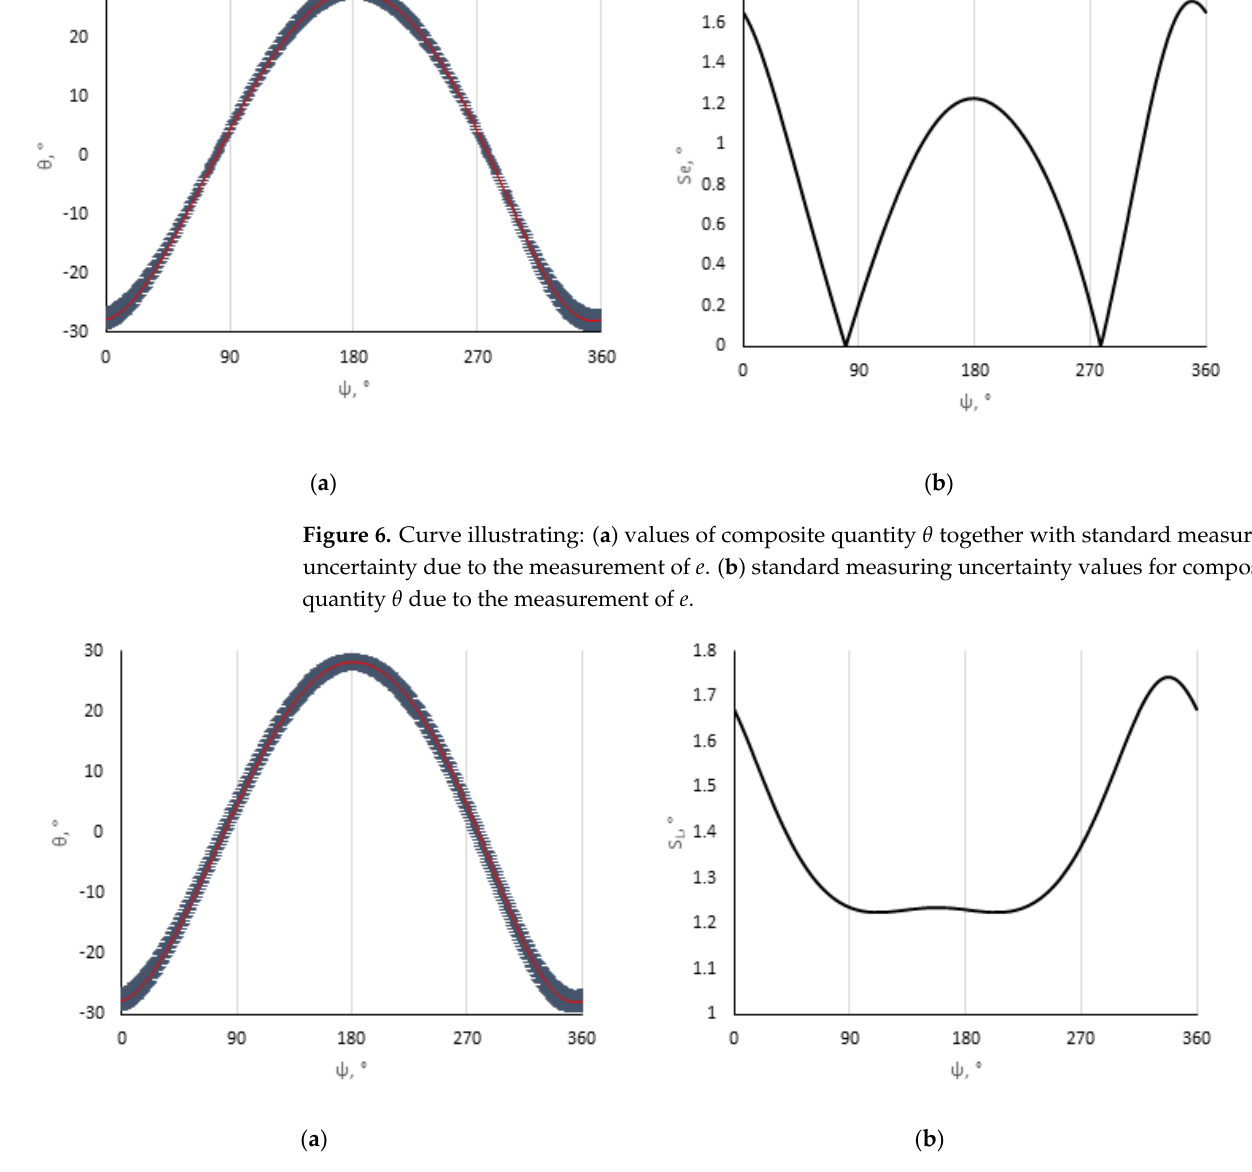
( b ) Figure 8. Curve illustrating : ( a ) values of composite quantity θ together with standard measuring uncertainty due to the measurement of d . ( b ) standard measuring uncertainty values for composite quantity θ due to the measurement of d . The smallest standard uncertainty of angle θ was caused by the measurement of ε (Figure 9). The highest value occurred for θ = 0° and totals ±0.35°. For θ max , standard un ‐ certainty was 0, which indicates that in this point θ is independent of ε .